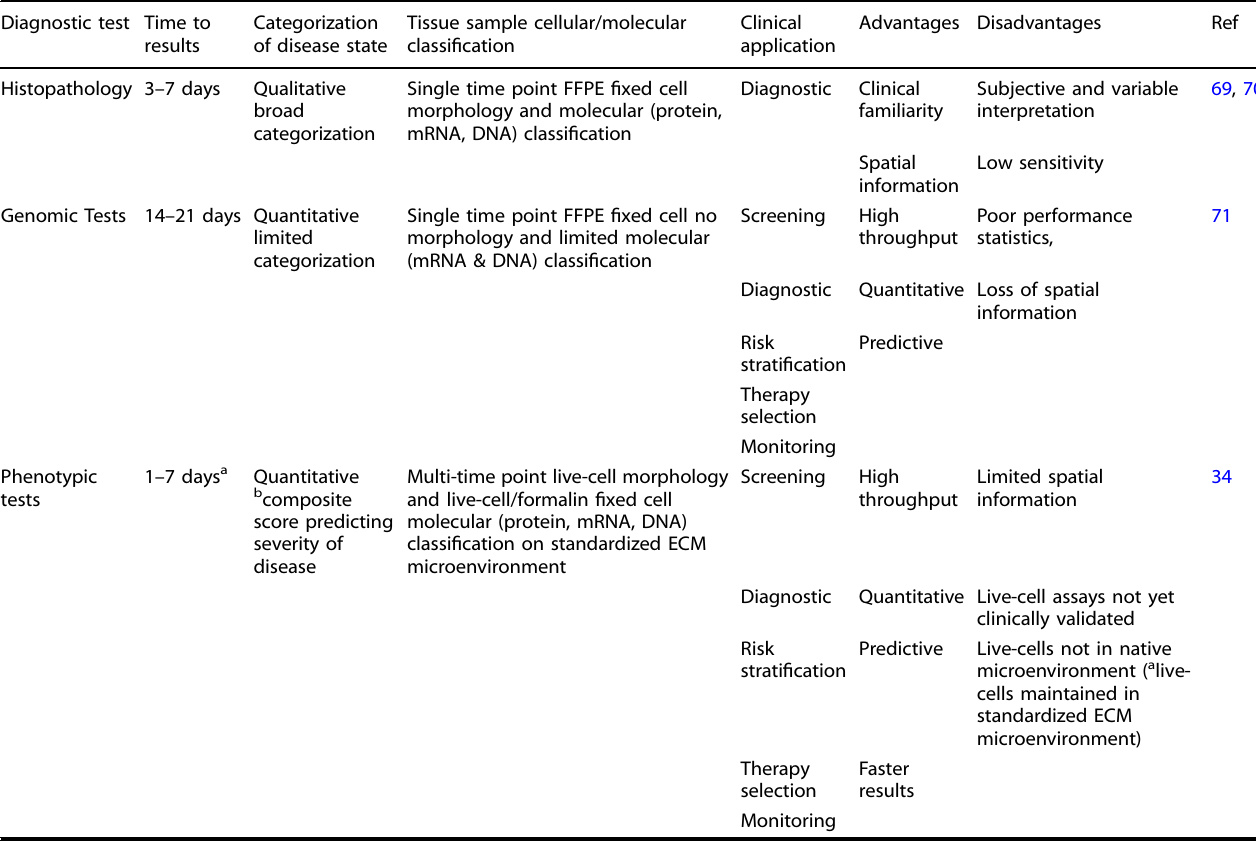
Table 2. Advantages and disadvantages of conventional, genomic, and phenotypic diagnostic tests Diagnostic test Time to